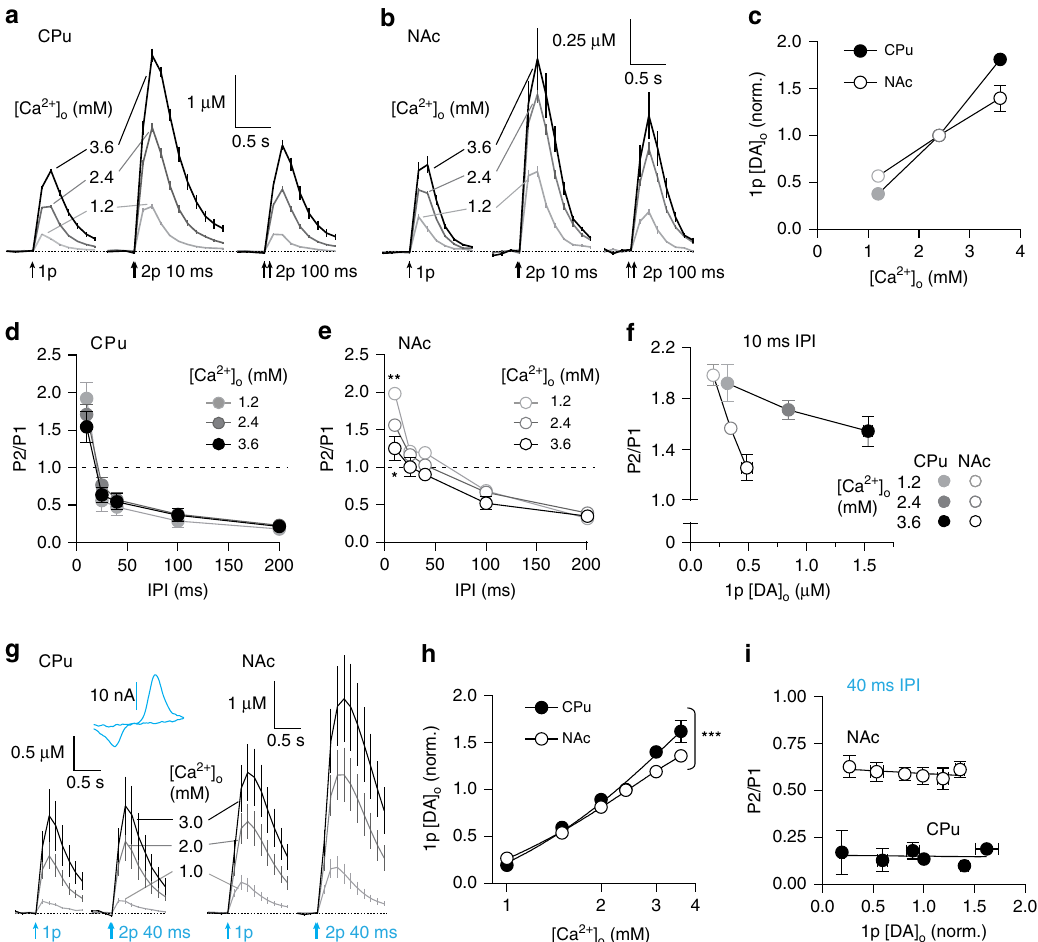
Fig. 2 Short-term plasticity is shaped by calcium-dependent facilitation and release-independent depression. a , b Mean pro fi les of [DA] o transients evoked by single or paired electrical pulses in 1.2 mM (light grey), 2.4 mM (dark grey) and 3.6 mM (black) [Ca 2 + ] o in CPu ( a , n = 3) and NAc ( b , n = 3). c Mean 1p-evoked [DA] o (normalised to 2.4 mM [Ca 2 + ] o ) vs [Ca 2 + ] o in CPu ( fi lled) and NAc (open circles). d , e Mean P2/P1 vs IPI in 1.2 mM (light grey), 2.4 mM (dark grey) and 3.6 mM (black) [Ca 2 + ] o in CPu ( d , fi lled) and NAc ( d , open circles). f Mean P2/P1 vs mean peak 1p [DA] o at 10 ms IPI in 1.2 mM (light grey), 2.4 mM (dark grey) and 3.6 mM (black) [Ca 2 + ] o in CPu ( fi lled) and NAc (open circles). g Mean pro fi les of [DA] o transients elicited by single or paired light pulses at 40 ms IPI (473 nm, 2 ms) in 1.0 mM (light grey), 2.0 mM (dark grey) and 3.0 mM (black) [Ca 2 + ] o in CPu (left, n = 3) and NAc (right, n = 3). Inset, representative voltammogram for optogenetically evoked DA release. h Mean peak 1p [DA] (log scale) evoked by light stimulation in CPu ( fi lled) and NAc (open circles). Second-order polynomial curve fi t; F-test of relative sum of squares shows curve fi ts are different. i Mean P2/P1 at 40 ms IPI vs mean peak 1p [DA] o evoked by optical stimulation in CPu ( fi lled) and NAc (open circles). Two-way ANOVA with Bonferroni ’ s test for post hoc comparisons except where stated otherwise: * P < 0.05, ** P < 0.01, *** P < 0.001. Error bars are ± SEM. Source data are provided as a Source Data fi